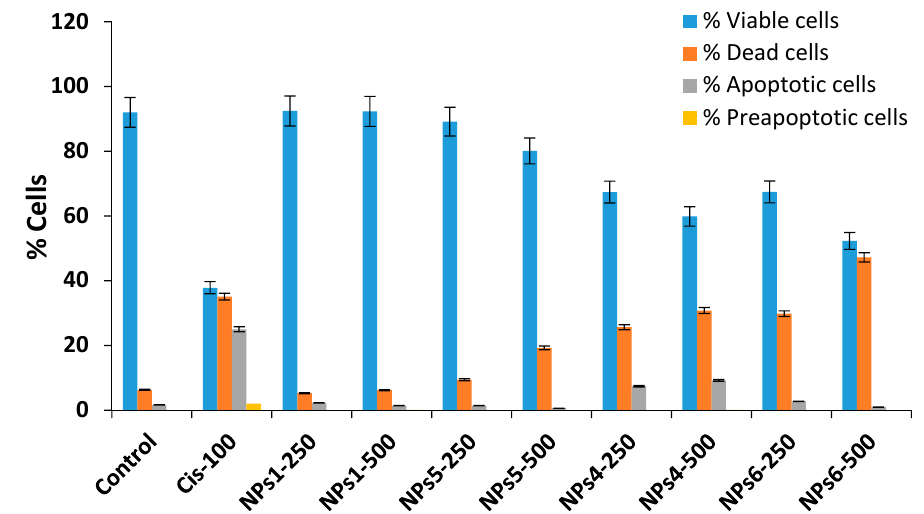
Figure 6. Comparison of the concentration effect of the 48-h treatment of all the NPs samples and Cis in the case of A375 neoplastic cell culture.